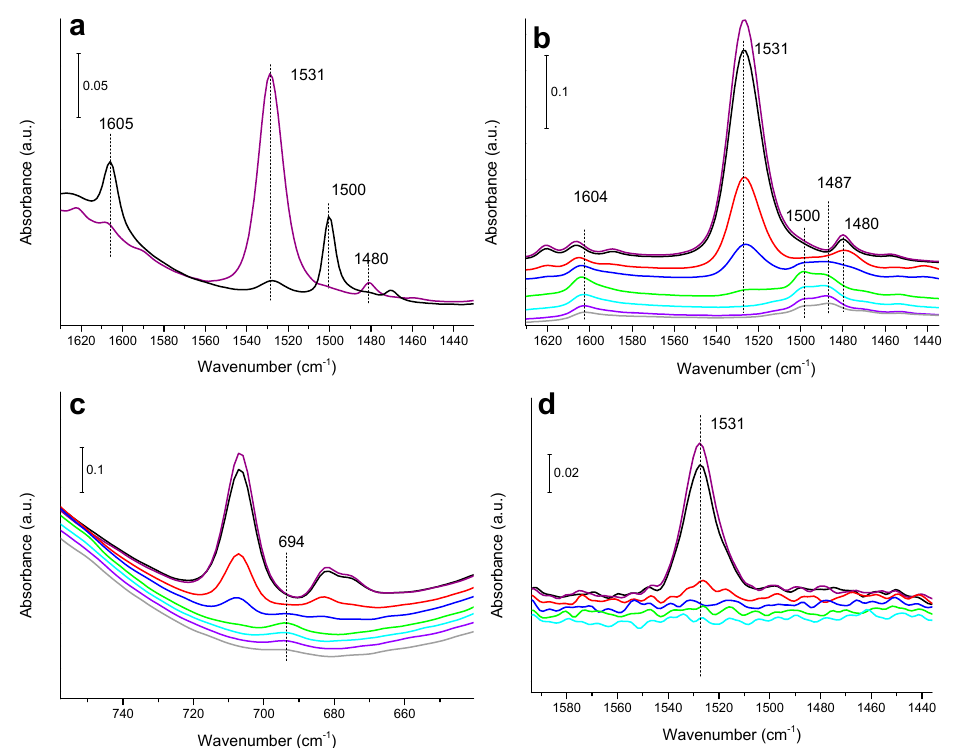
Figure 2. IR spectra of nitrobenzene and H 2 co-adsorbed on: ( a ) Pd/SiO 2 , ( b ) Ni/SiO 2 and ( c ) Ni/SiO 2 in the low frequency range, ( d ) Cu/SiO 2 and their reactivity at increasing reaction temperature: 25 °C (black), 60 °C (red), 90 °C (blue), 120 °C (green), 140 °C (cyan), 180 °C (violet) and 200 °C (grey). Purple colored line corresponds to the sample after nitrobenzene and before H 2 co-adsorption at 25 °C.